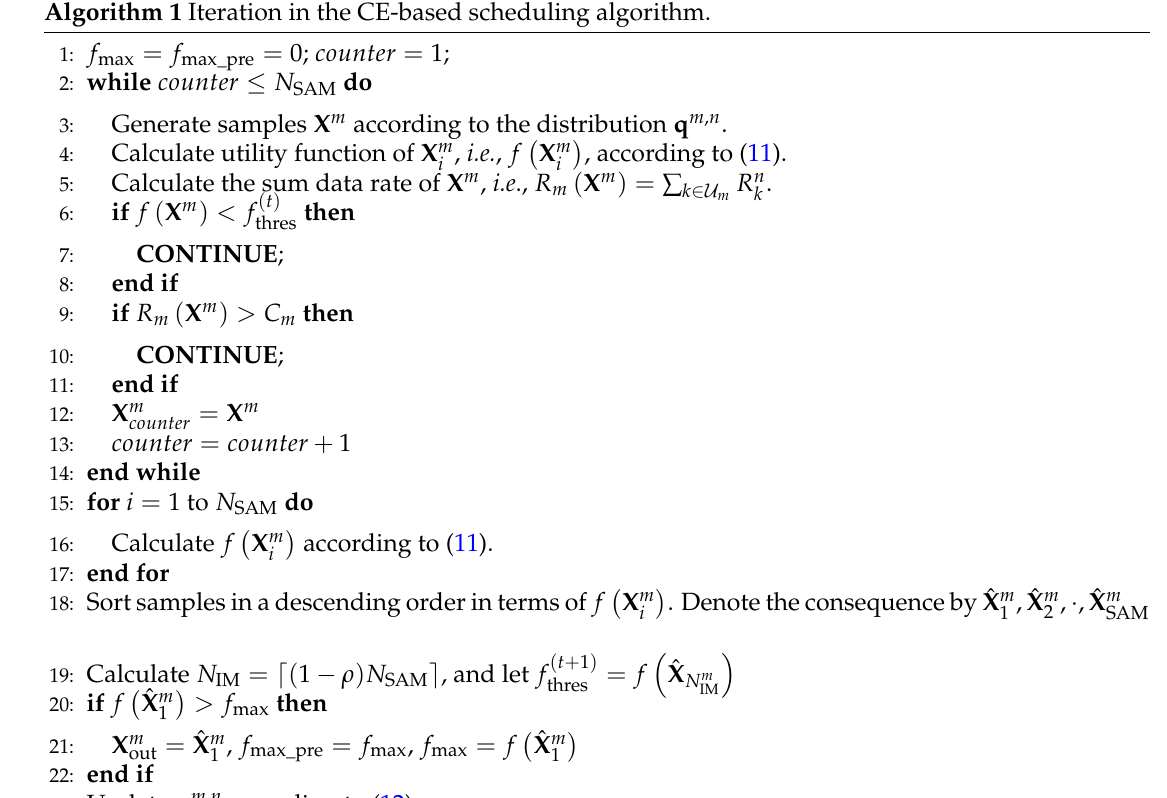
Algorithm 1 Iteration in the CE-based scheduling